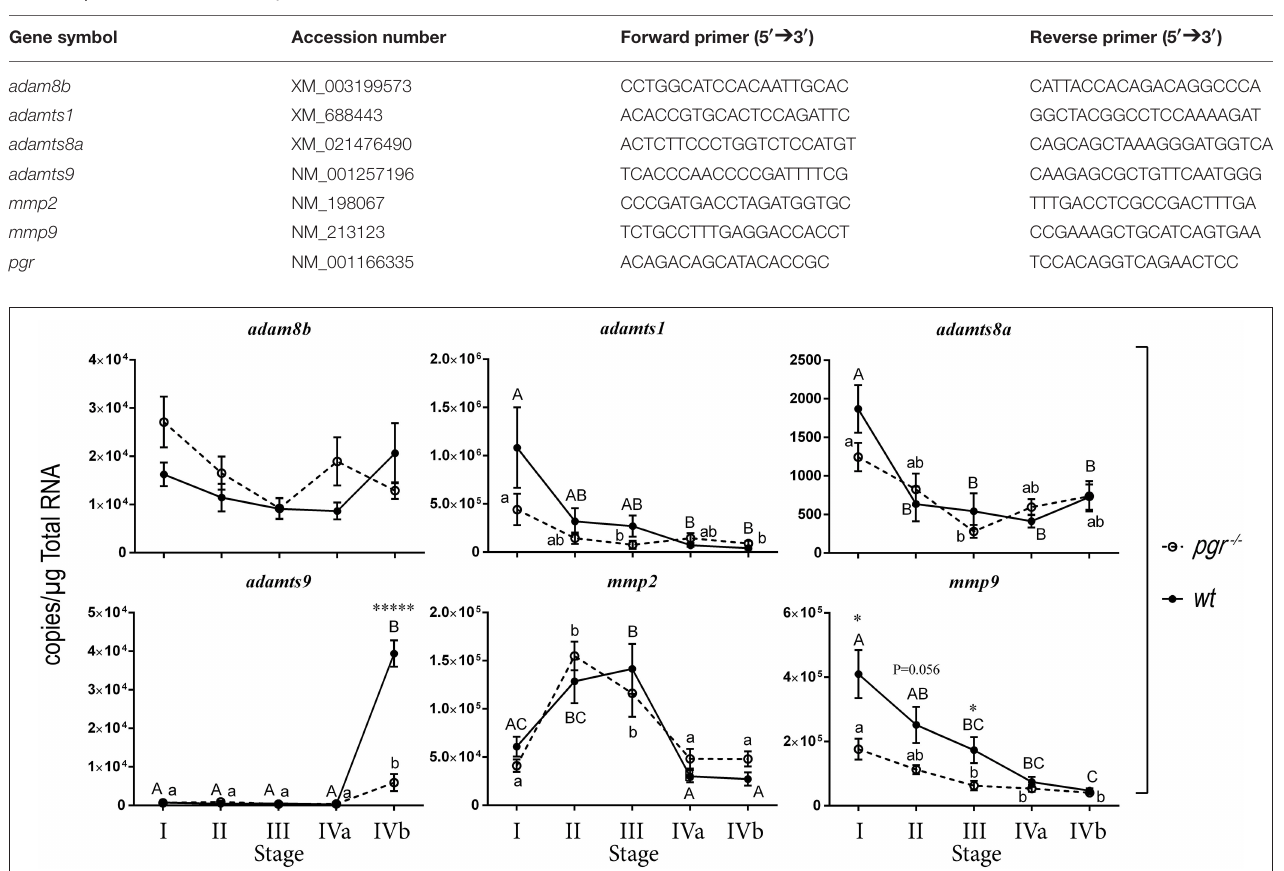
FIGURE 1 | Expression of representative metalloproteinases in various stages of follicles (follicular cells-enclosed oocytes) in wildtype ( wt , solid line with filled circles) and Pgr knockout zebrafish ( pgr − / − , dashed line with open circles) in vivo . All transcripts were determined and expressed as absolute value according to standard curves established with known concentrations of serially diluted plasmids using real-time quantitative PCR (qPCR). Stages of zebrafish follicles were classified per Selman et al. ( 28). Stage IV follicles were further sub-divided into stage IVa and stage IVb. Stage IVa follicles were fully-grown immature follicles prior to oocyte maturation. Stage IVb follicles were follicular cells enclosed mature oocytes that have gone through oocyte maturation, but not yet ovulated (also see Table 1 for detail). Different letters (uppercase for wt ; lowercase for pgr − / − ) indicate significant differences among different follicular stages in wt or pgr − / − fish. Significant differences between wt or pgr − / − fish at the same developmental stage of follicles are indicated by asterisks. * p < 0.05, ***** p < 0.00001. N = 6. The metalloproteinases examined were adam8b , a distintegrin and metalloproteinase domain 8b; adamts1 , a disintegrin and metalloproteinase with thrombospondin